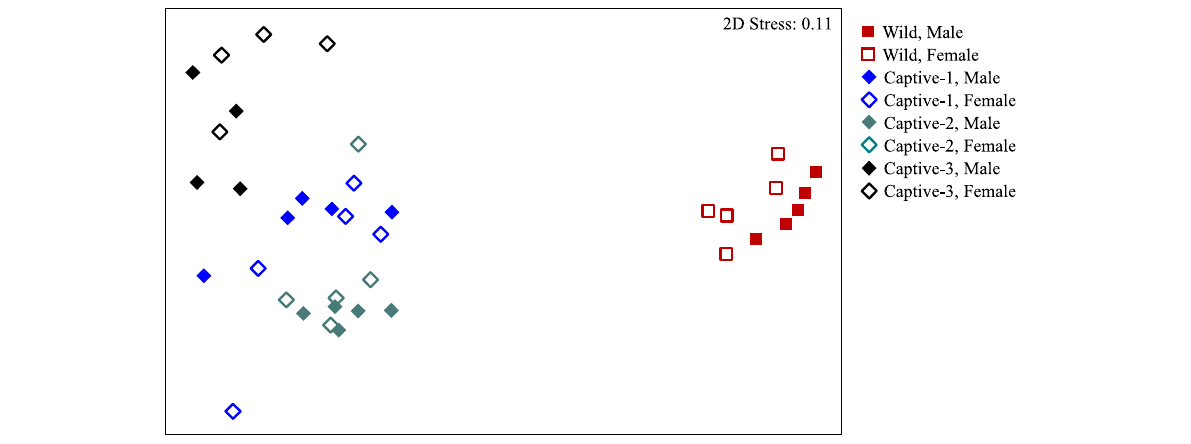
Fig. 2 Multidimensional scaling (MDS) plot relating microbiota composition to sampling period and